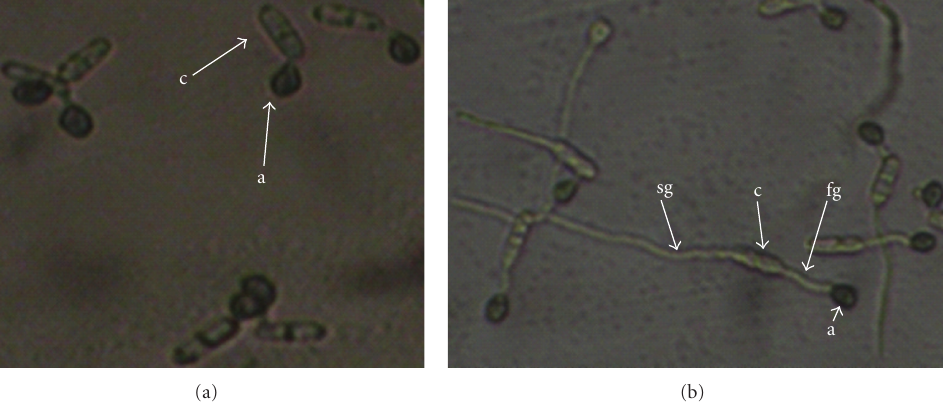
Figure 7: The C. gloeosporioides wild type (A) strain and Cgpkac1 mutant (B) displaying appressoria and bidirectional germ tubes. The image was captured with an Olympus phase contrast microscope (200x magnification) and a Nikon digital camera. (a: appressorium; c: conidium; fg: first germ tube; sg: second germ